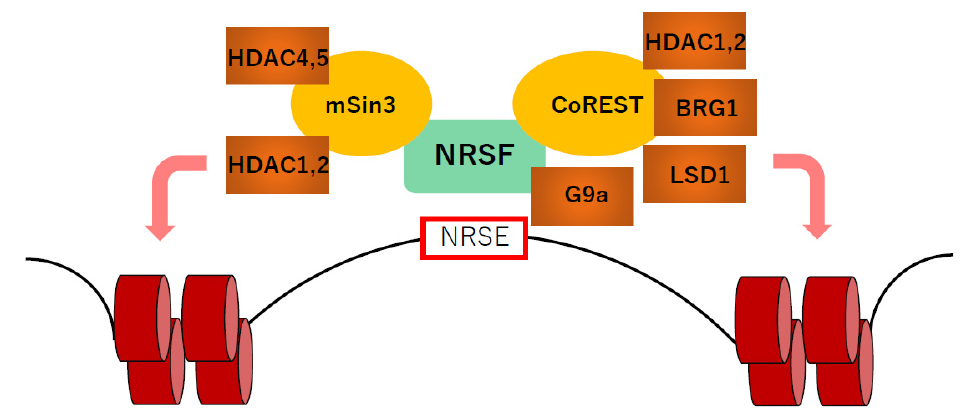
Figure 2. NRSF forms a repressor complex with epigenetic modifiers and cooperatively regulates gene expression. HDAC, histone deacetylase; LSD1, lysine (K)-specific demethylase 1A; NRSE, neuron-restrictive silencer element; NRSF, neuron-restrictive silencer factor.